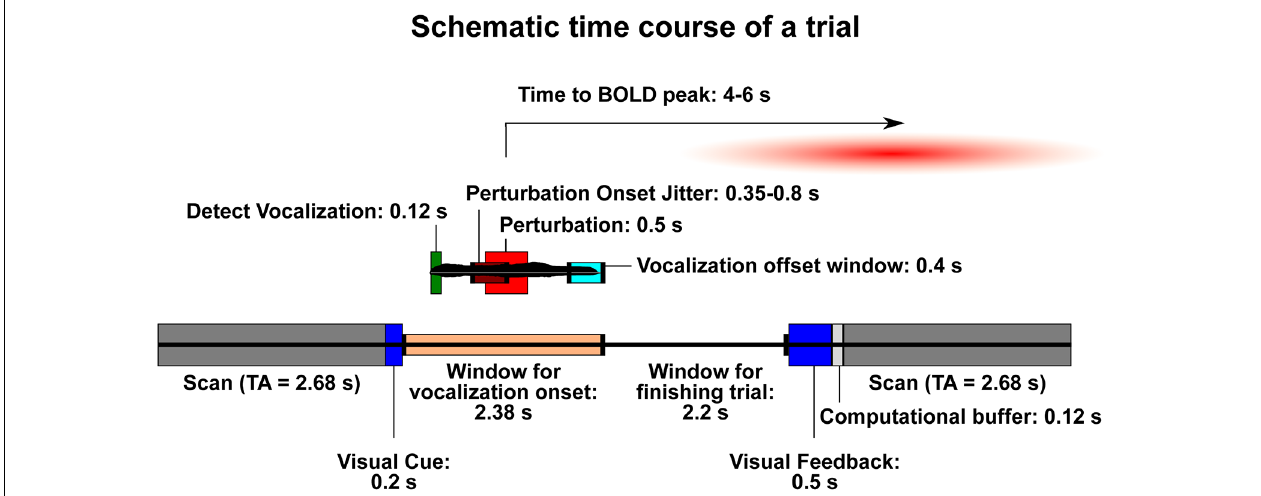
FIGURE 1 | Schematic time course of a trial. The lower bar represents events that are not related to the onset of vocalization in each trial. The smaller bar above it (with a sample vocal trace in black) represents the trial time course once vocalization has begun. Trials are designed such that the blood-oxygen-level-dependent signal (BOLD) signal resulting from the perturbation will be likely to peak during the following acquisition. Dark gray: acquisition scan (brain activity recorded). TA, acquisition time (2.68 s). Dark blue: visual displays for trial onset and feedback. Peach: window of time during which a participant may begin vocalization. Light gray: buffer time necessary to process the trial and be ready for the next one. Dark green: time needed for the Audapter software to recognize vocalization. Maroon: time frame within which the perturbation will begin on a shifted trial (jittered). Red: duration of perturbation (always 500 ms). Turquoise: time window in which participants should stop vocalization in order to receive “success” during visual